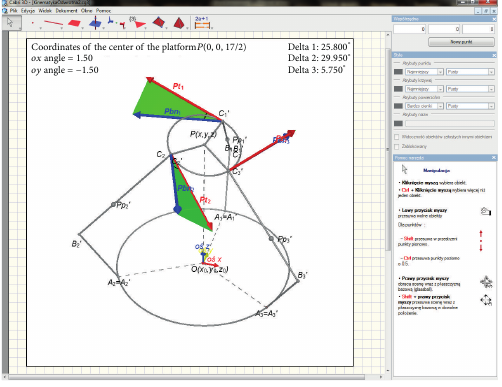
Figure 16: Geometric model build in Cabri Geometry